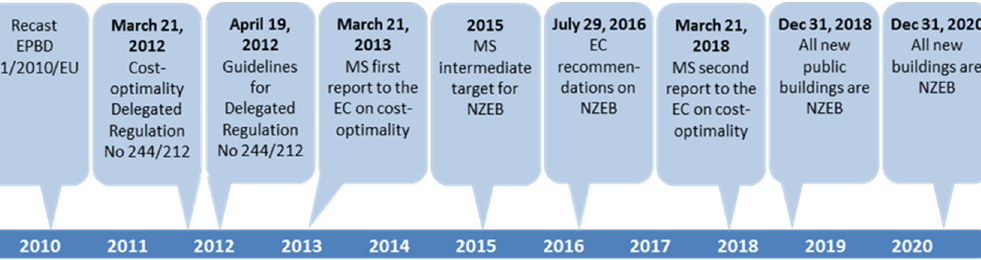
Table 1. Reference categories.